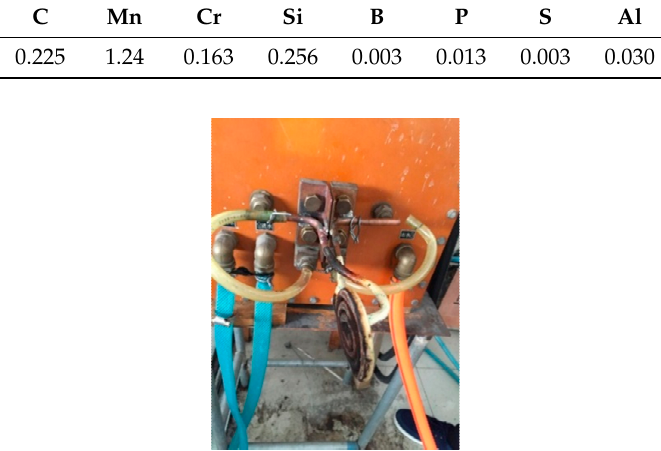
Table 1. Chemical compositions of 22MnB5 (mass %).